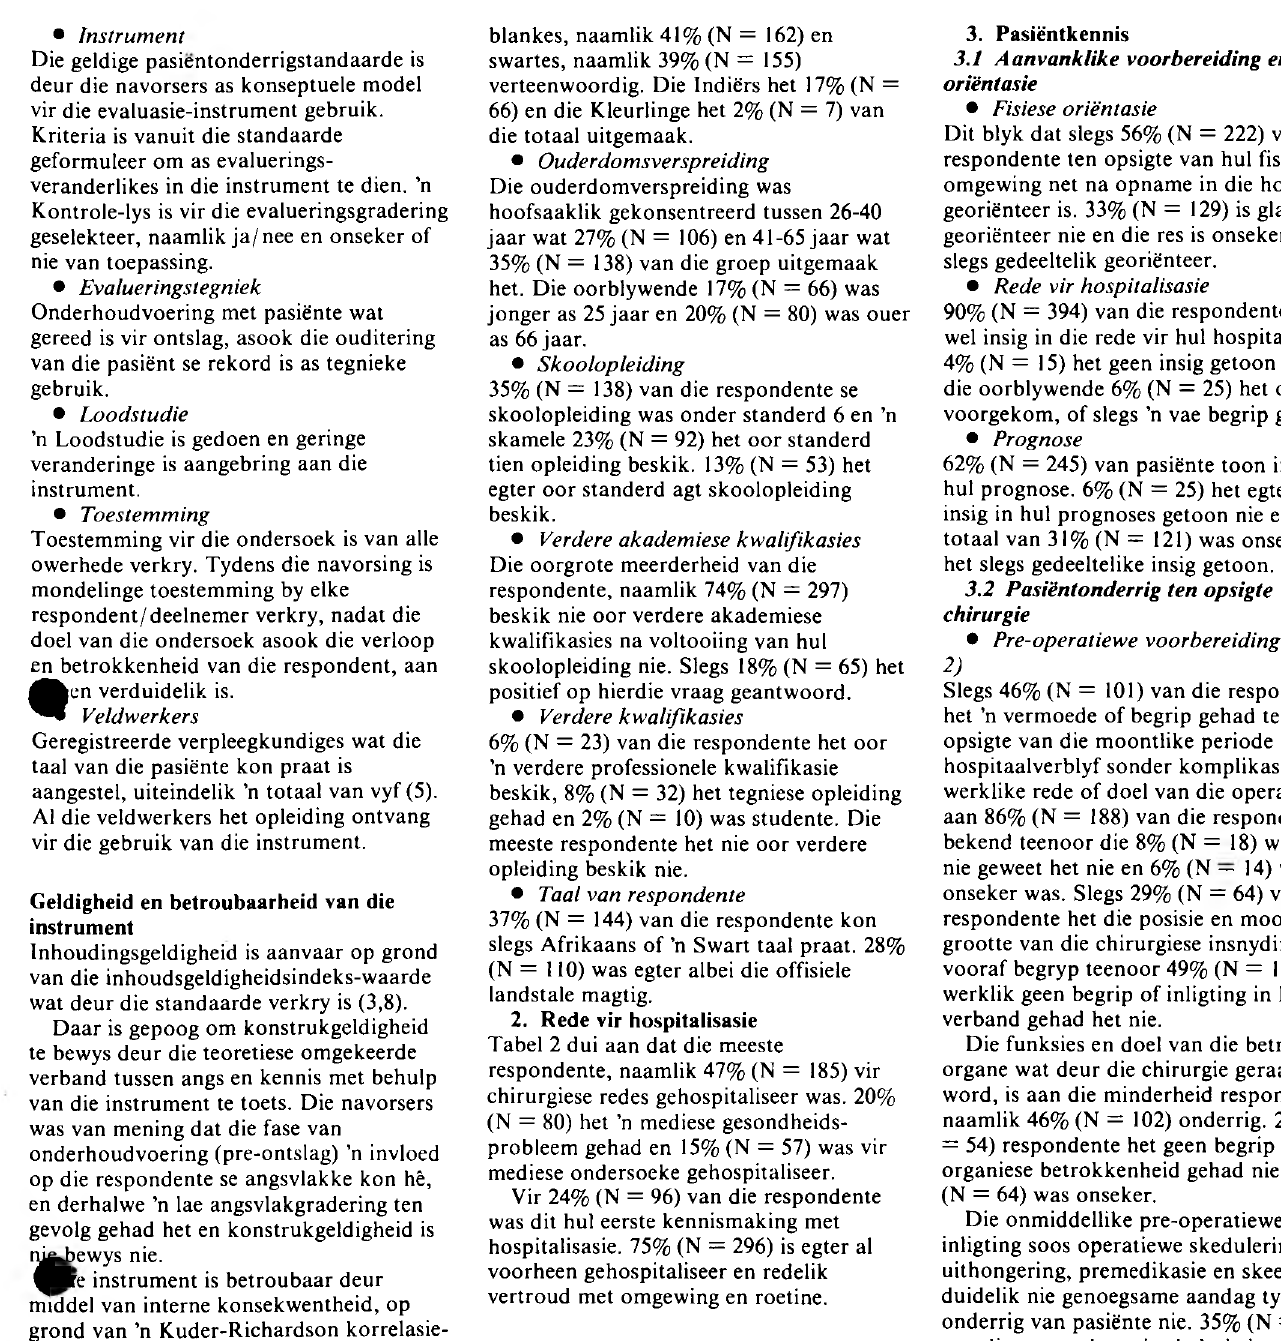
TABEI. 2 Rede vir